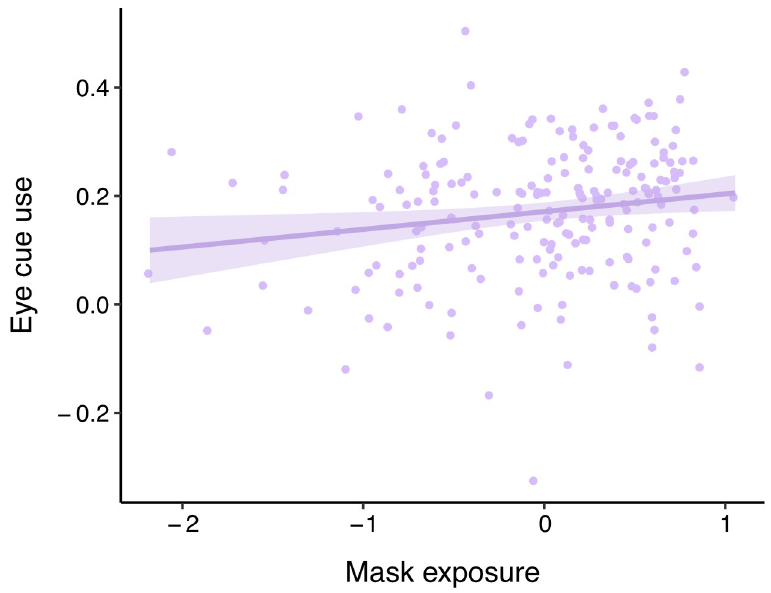
Fig 4. Effect of mask exposure on eye cue use in Study 1. Use of eye cues in emotion judgements increased as exposure to masks increased. Transparent band reflects 95% confidence interval. Created using ggplot2 (v3.3.0) in